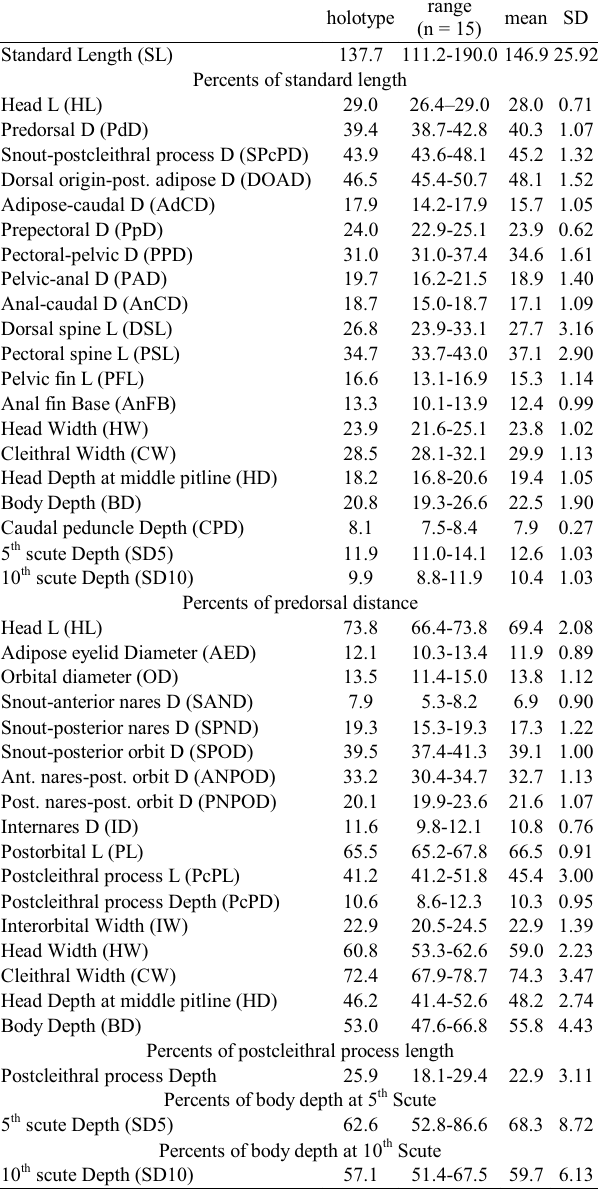
Table 2. Morphometrics of Platydoras brachylecis , new spe- cies, reported for holotype, MZUSP 43593, and all measured specimens (n = 15 total).